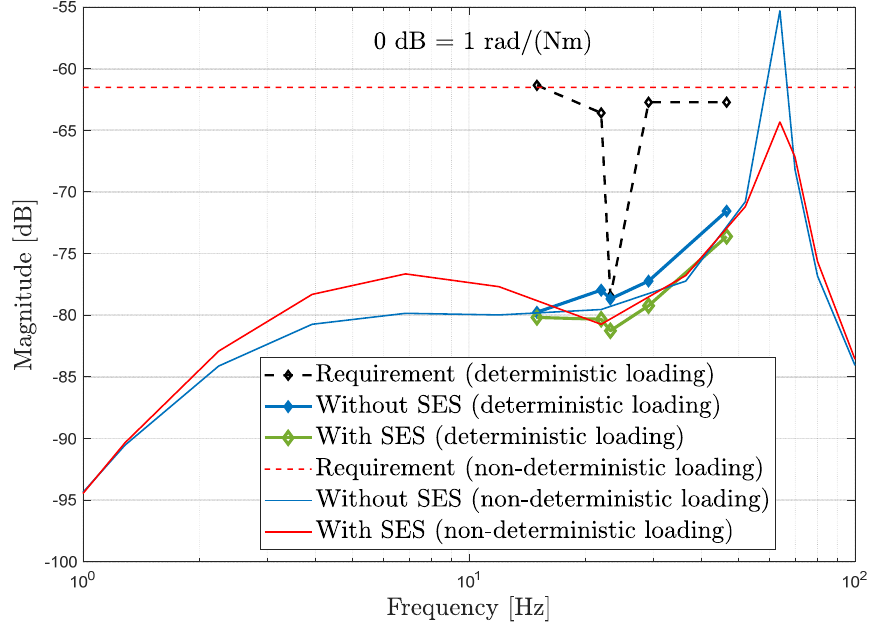
Figure 14. EMA dynamic compliance response: simulation results obtained with the experimentally validated model of the actuator (position setpoint corresponding to minimum stiffness).